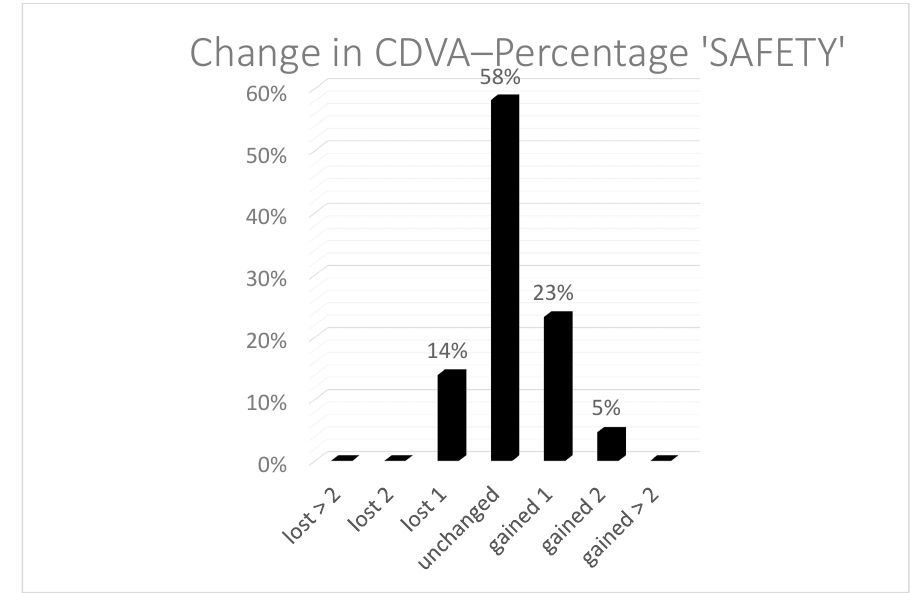
Figure 2. Safety. Comparing lines of vision preoperatively and 3 months postoperatively. No eye lost two or more lines after TransPRK in the eyes treated with clear lens extraction, and 4% of the eyes gained two lines of Snellen acuity.